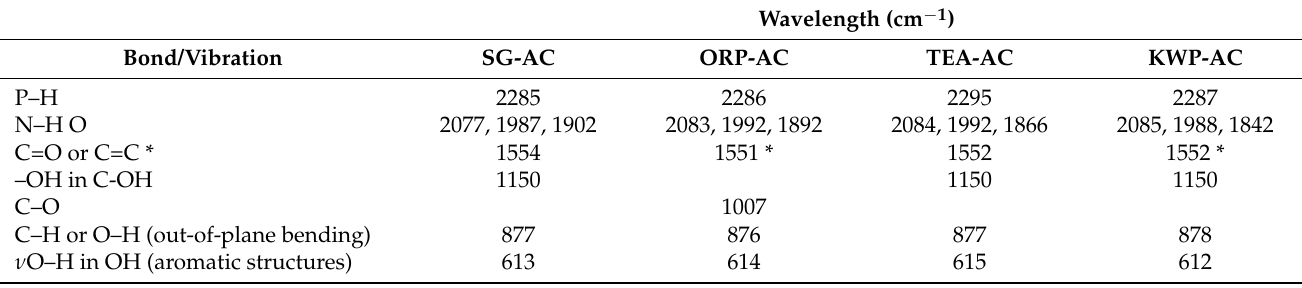
Table 1. FTIR bands based on different bonding.